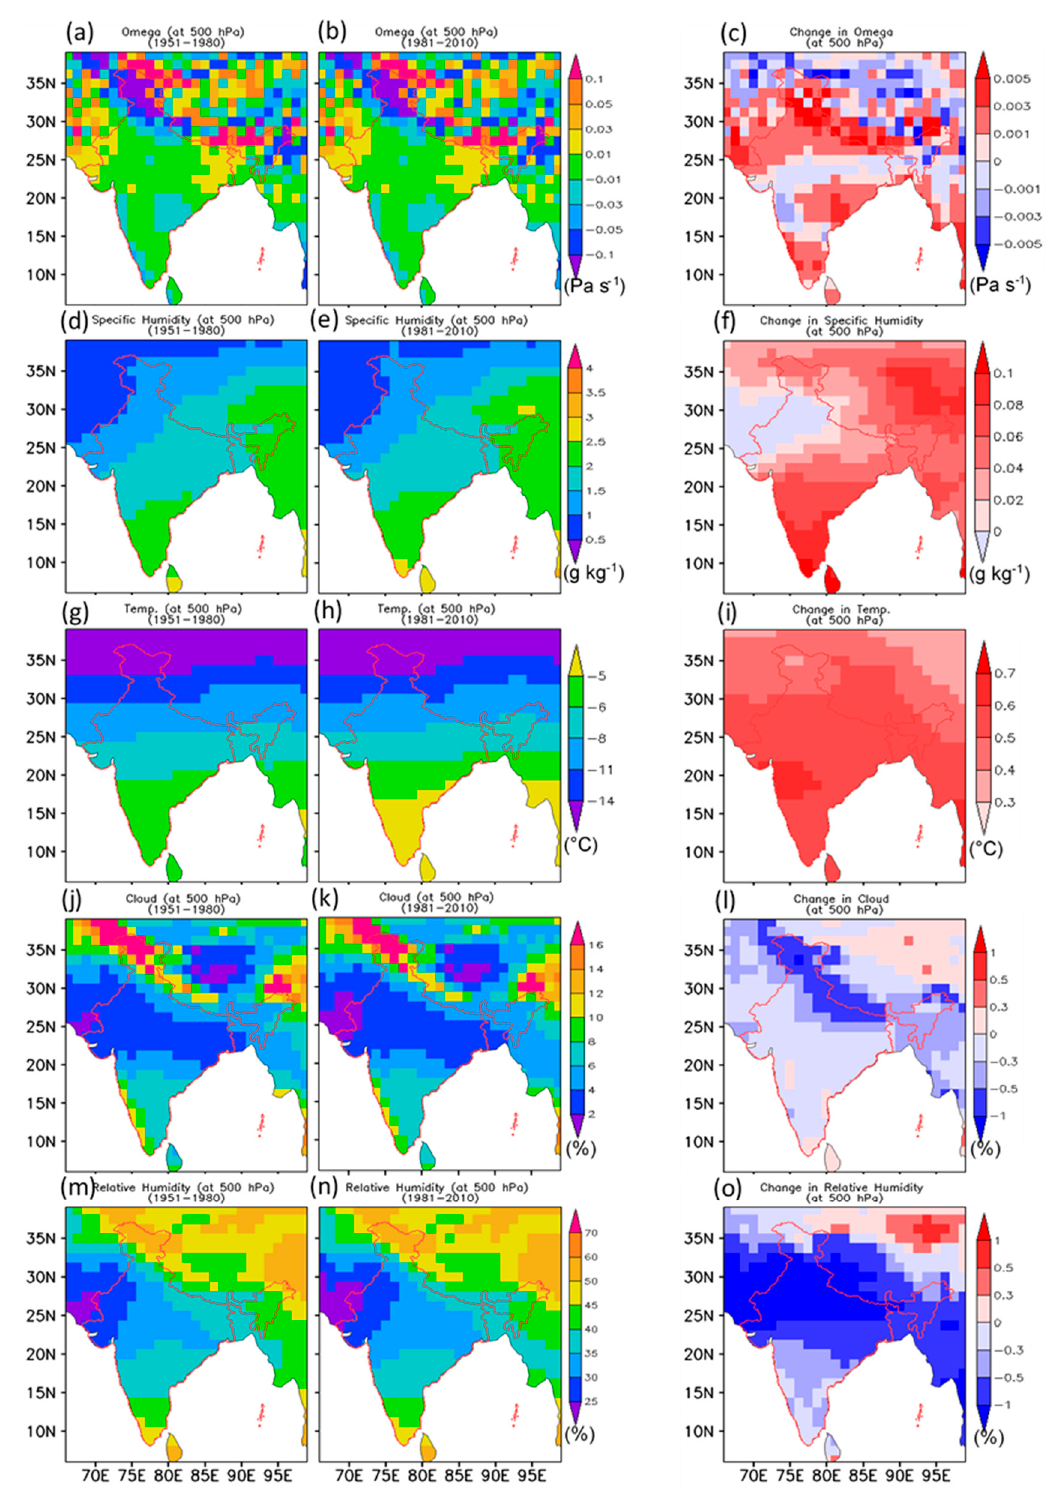
Figure 12. Climatogies in two climate periods at 500 hPa and change in ( a – c ) omega, ( d – f ) specific humidity, ( g , h ) temperature, ( i – k ) Cloud cover, and ( l – o ) relative humidity. 1st panel corresponds to the results for the period 1951–1980, 2nd panel corresponds to the results for the period 1981–2010, and 3rd panel corresponds to their change in recent period.